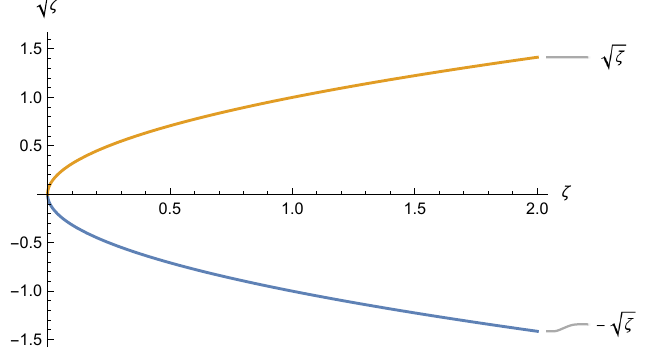
Figure 1. The plot of the function ˘ Υ = [ ˘ Υ , ˘ Υ ]